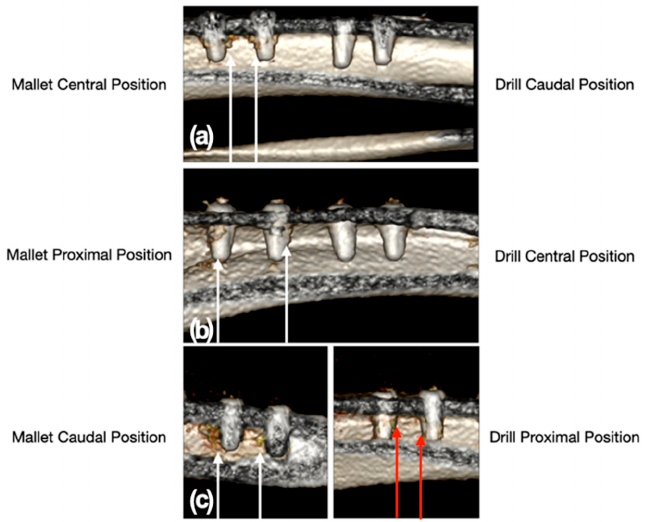
Figure 5. CT scan images of the position of the implant sites relative to the tibial bone. Panel ( a ): mallet in central and drill in caudal position; panel ( b ): mallet in proximal and drill in central position; panel ( c ): mallet in caudal and drill in proximal position. The white arrows indicate the two sites, with the relative implants, prepared with the mallet technique. In these sites, a moderate